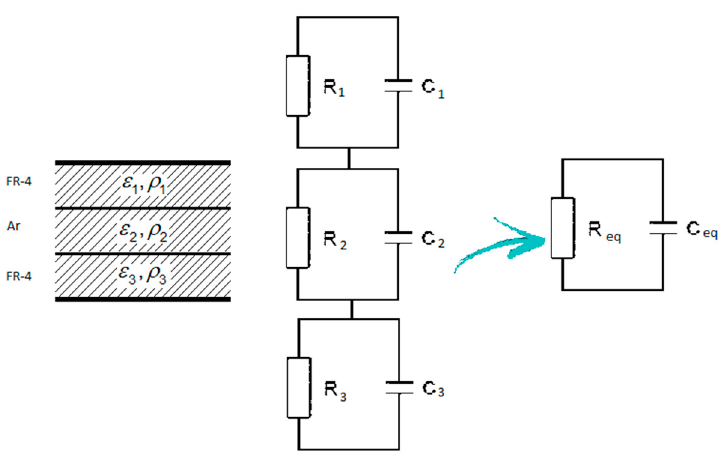
Figure 10. Representation of the equivalent circuit of antenna substrates with FR-4 [18].